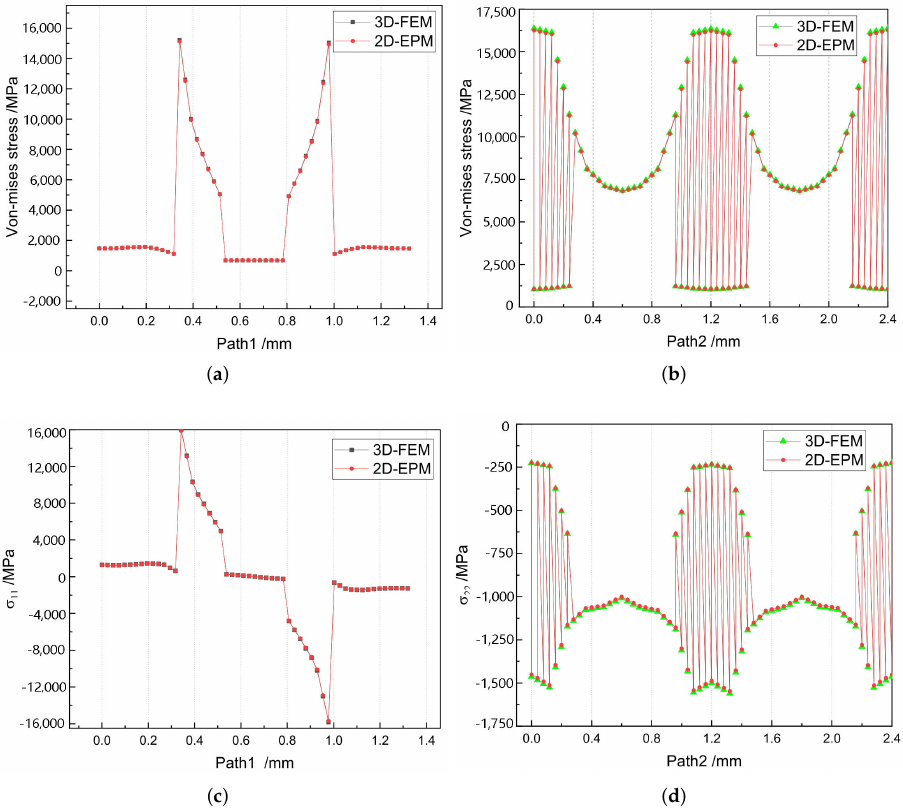
Figure 10. Comparison of local stress distributions along Path 1 and Path 2 of the unit cell predicted by two models under the conditions in Case 2. ( a ) Von mises stress along Path 1; ( b ) Von mises stress along Path 2; ( c ) σ 11 along Path 1; and ( d ) σ 22 along Path